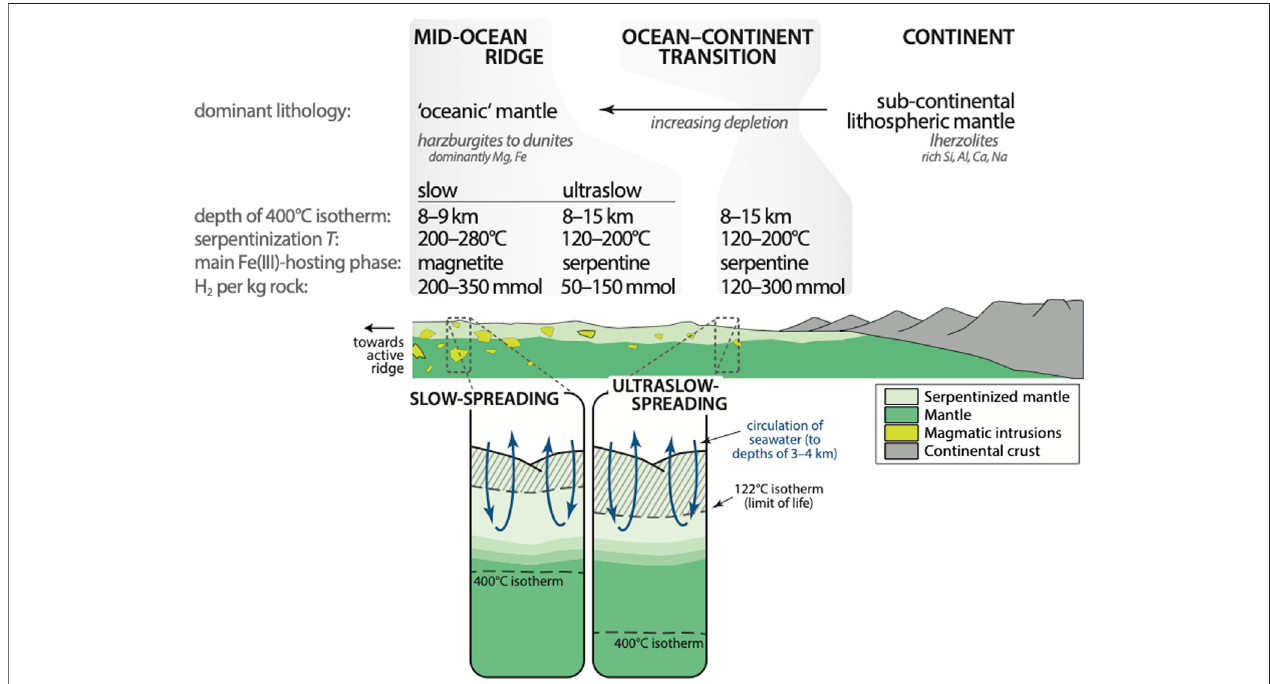
FIGURE 10 | Conceptual sketch of serpentinization-related H 2 production from rift to ridge (active MOR toward the left). These general changes in H 2 production likely apply to the majority of magma-poor rifted margins as well as ultraslow- and slow-spreading MORs. Lithological changes and variations in geotherms, the latter being strongly dependent on the extension rates, result in distinct serpentinization phase assemblages. At ultraslow rates, large volumes ofserpentinite should produce H 2 under conditions close to/within the habitable zone (lower right inset). See main text for further discussion. Limit of life after Takai et al. (2008).